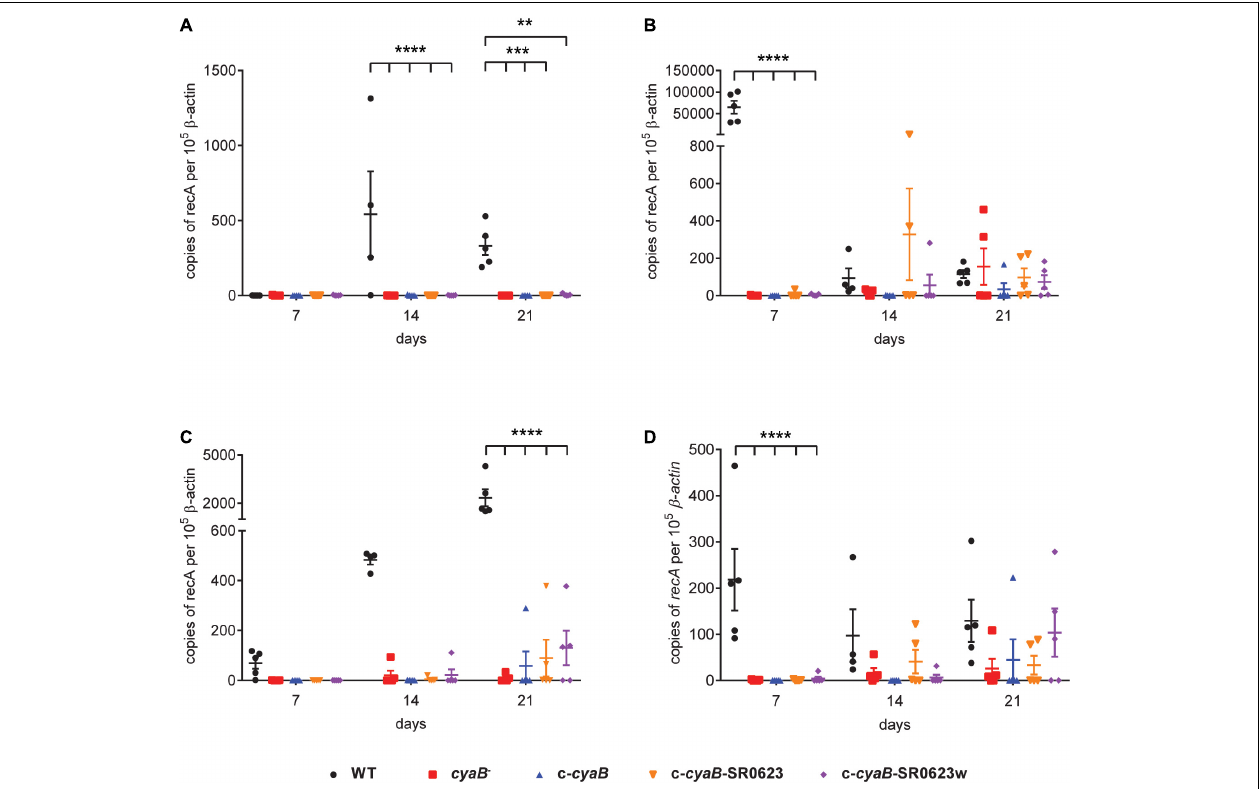
FIGURE 7 | Borrelial burden and tissue dissemination is reduced in mouse tissues infected with the cyaB mutant. C3H/HeN mice were infected with 10 5 Borrelia burgdorferi and tissues were harvested at 7, 14, and 21 dpi. qPCR was performed on (A) ears, (B) skin flanks, (C) joints, and (D) bladders to determine the number of borrelial genomes ( recA ) per 10 6 copies of mouse β -actin. Individual data points with at least n of 4 with lines representing average and standard error. Statistical analysis was done using two-way ANOVA with Dunnett correction relative to WT, ** p -value < 0.01, *** p -value < 0.001, **** p -value <